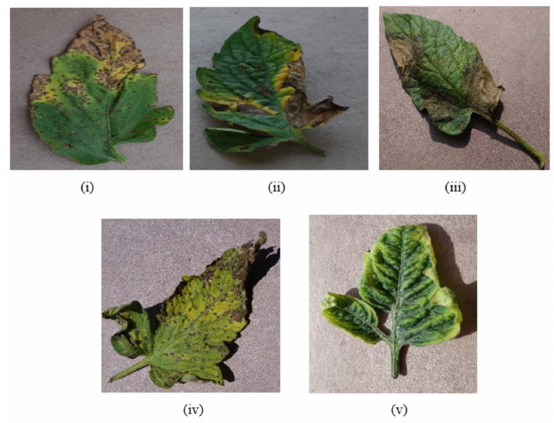
Figure 4. Tomato Leaf Diseases: ( i ) Bacterial Tomato spot ( ii ) Early Tomato Blight ( iii )Tomato Late Blight ( iv )Tomato Septoria leaf spot ( v )Tomato Yellow Leaf Curl Virus.